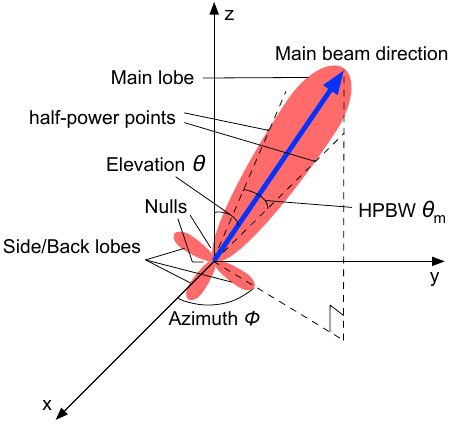
Figure 1. Realistic directional